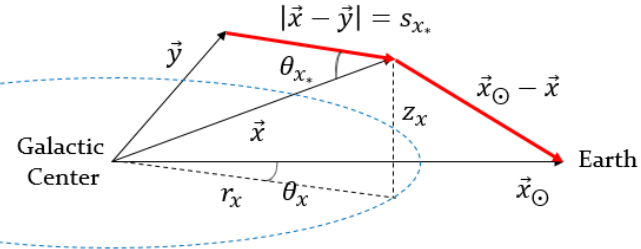
Figure 2 . Schematic situation from production and decay of at ~y and ~x to propagation of e (cid:6)